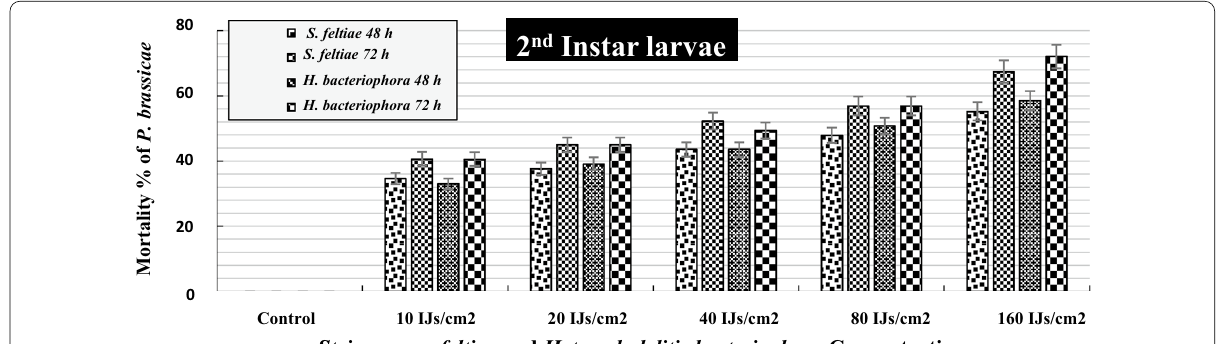
Fig. 1 Efficacy of Steinernema feltiae and Heterorhabditis bacteriophora against 2nd instar P. brassicae larvae